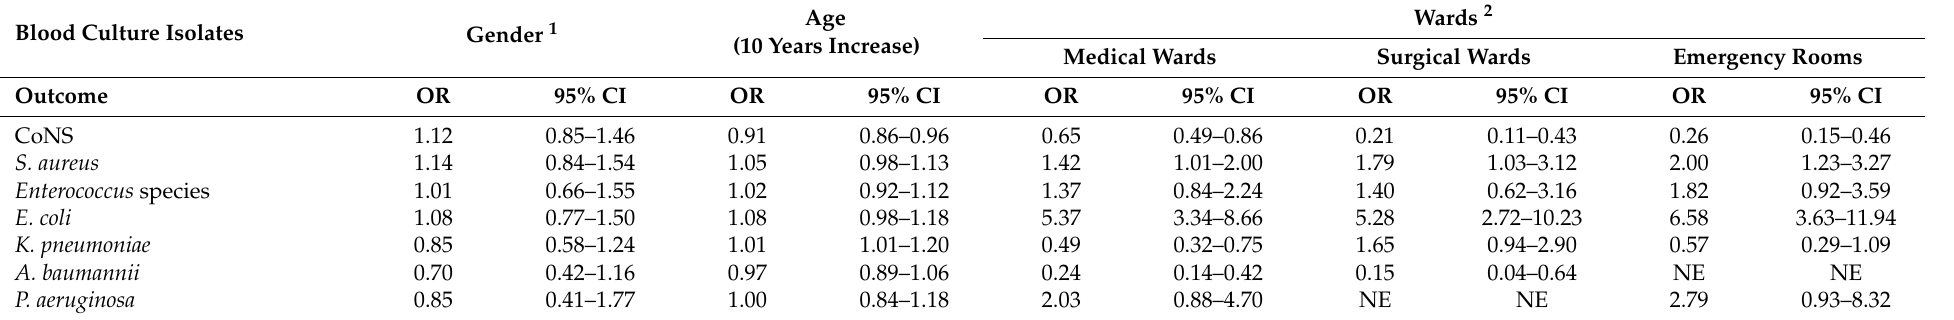
Table 5. Results of binomial logistic regression